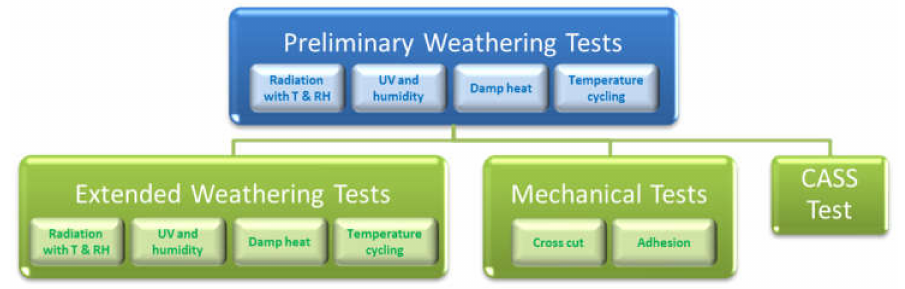
Figure 6. Scheme of the test